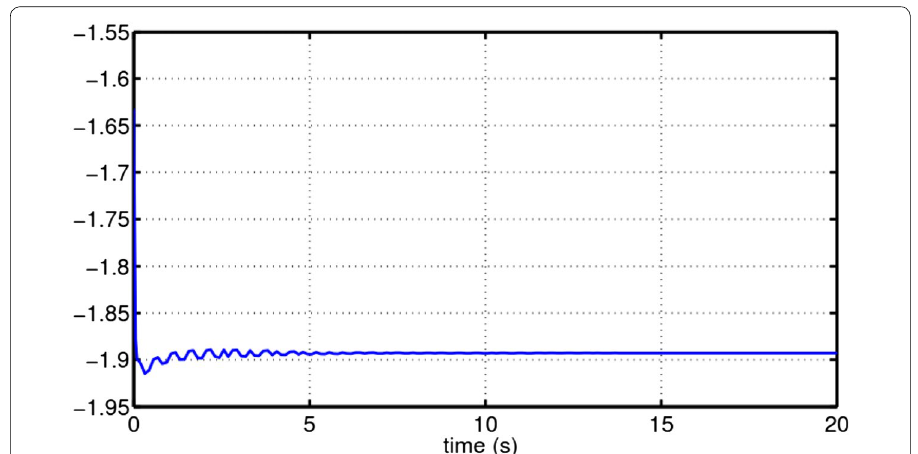
Fig. 6 The reactive power of DG source with increases in static load of 1%